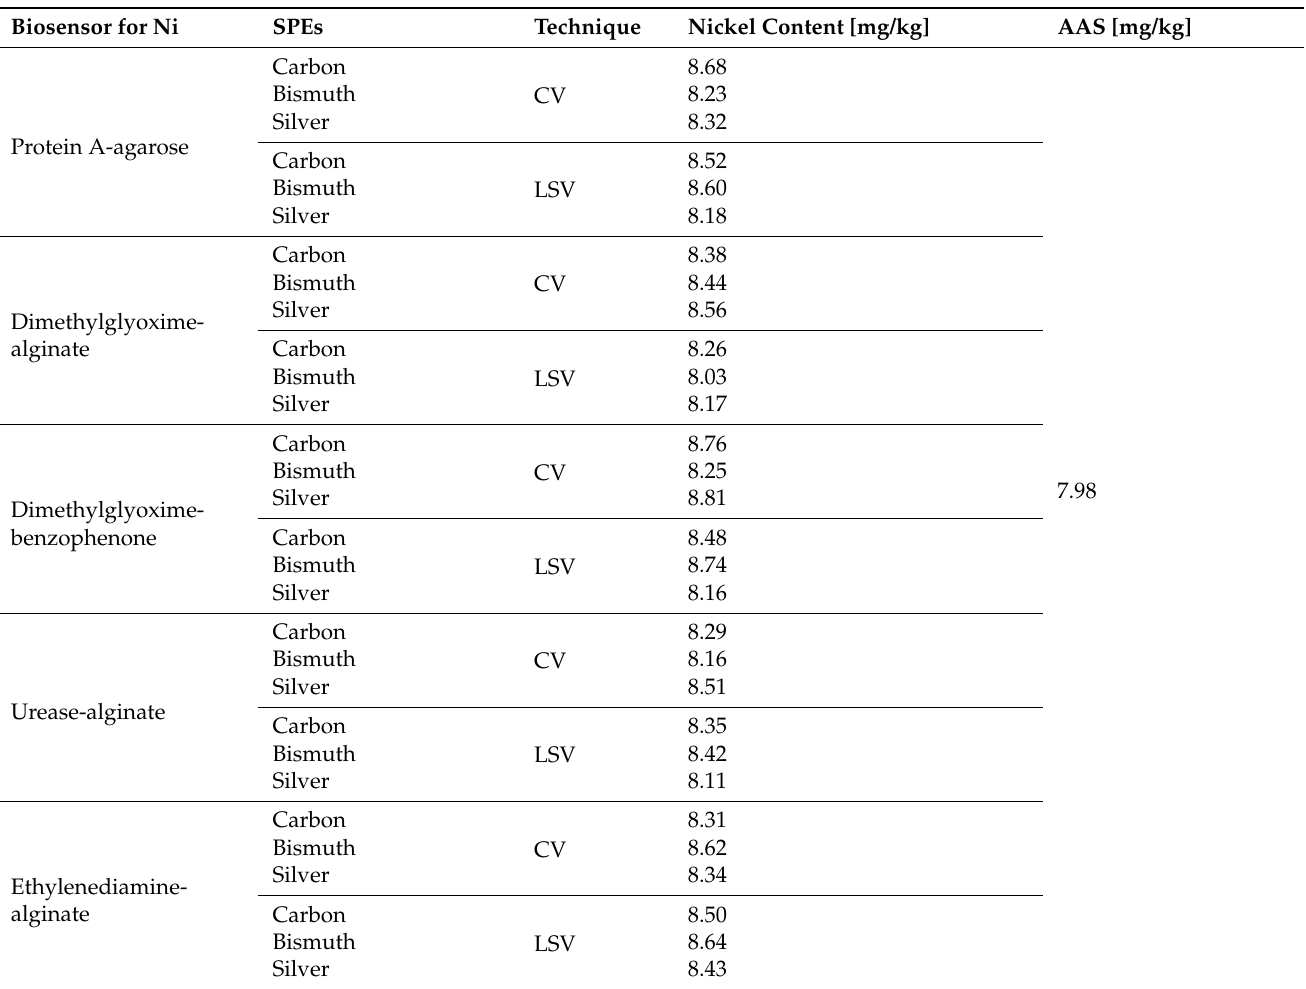
Table 2. Nickel content in mushrooms ( Armillaria mellea ).